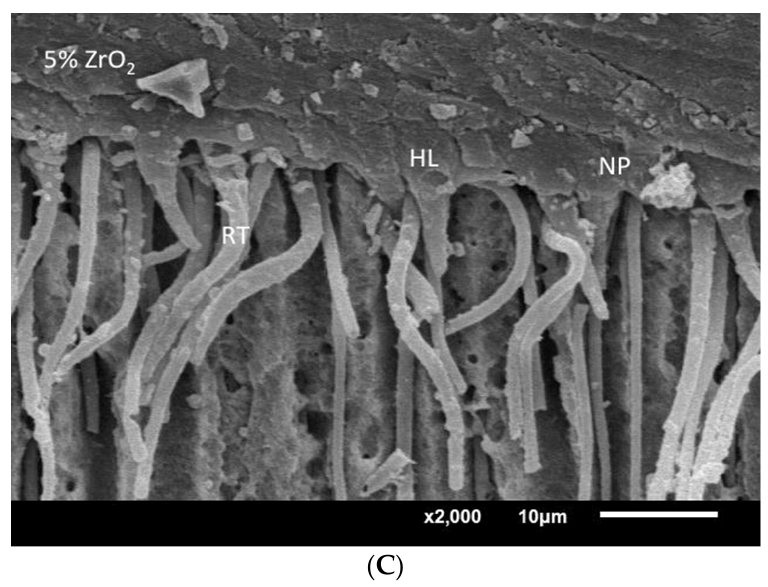
Figure 8. SEM assessment of resin–dentin interface specimens bonded with EA, 5% TiO 2 and 5% ZrO 2 . ( A ) EA showing dentin penetration with resin tag (RT) and hybrid layer (HL) formation. ( B ) 5% TiO 2 adhesive showing thick hybrid layer and resin tags similar to EA samples with dispersed particles (NP). ( C ) 5% ZrO 2 adhesive showing developed HL and RT with isolated ZrO 2 NP.